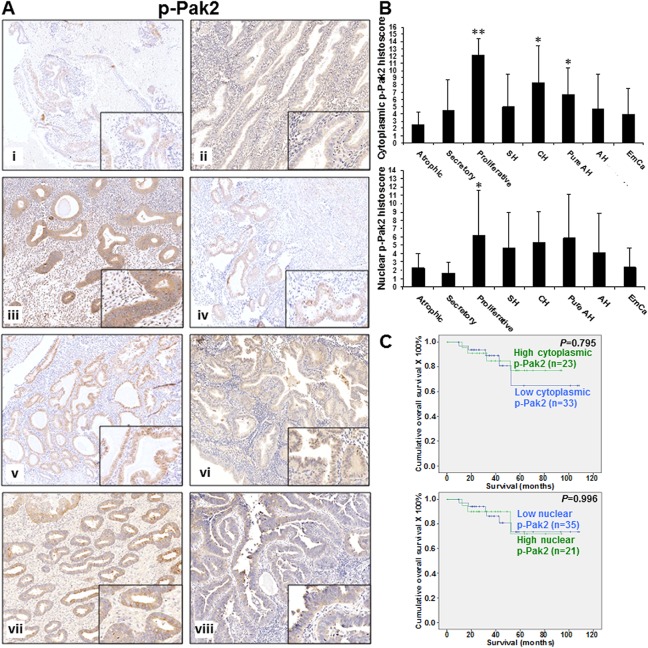
(A) p-Pak2 immunoreactivity in normal atrophic endometrium (i), secretory endometrium (ii), proliferative endometrium (iii), simple hyperplasia (iv), complex hyperplasia (v), pure atypical hyperplasia (vi), atypical hyperplasia (vii) and endometrial cancers (viii). (B) Bar chart showing the immunoreactivity of cytoplasmic (upper panel) and nuclear (lower panel) p-Pak2 in normal atrophic endometrium (Atrophic), secretory endometrium (Secretory), proliferative endometrium (Proliferative), simple hyperplasia (SH), complex hyperplasia (CH), pure atypical hyperplasia (Pure AH), atypical hyperplasia (AH) and endometrial cancers (EmCa). *, P<0.05; **, P<0.005; compared to normal atrophic endometrium by Mann-Whitney test. (C) Kaplan-Meier survival curves for endometrial cancer patients with two different expression levels of cytoplasmic (upper panel) and nuclear (lower panel) p-Pak2 (cut off at mean).